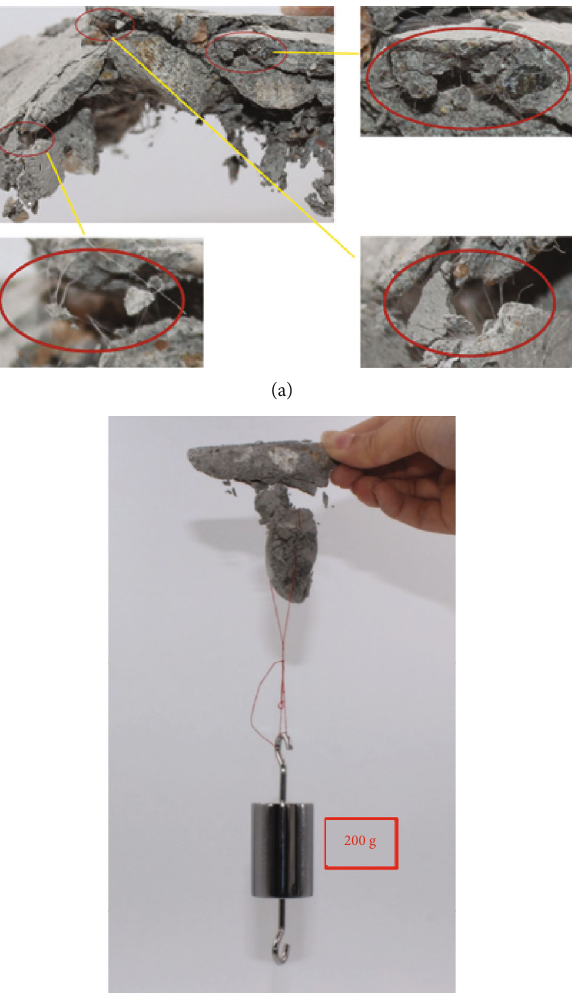
Figure 6: (a) The diagram for forming connecting bridge by fi bers and (b) the weight of PPFRC